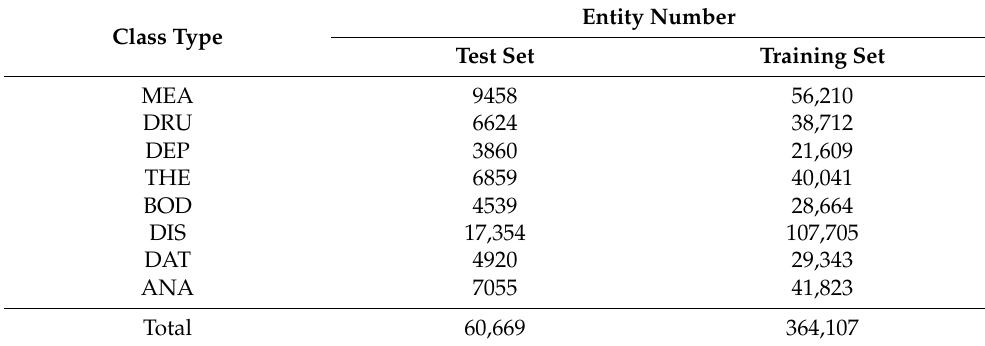
Table 4. Number of entities in the final annotated corpus, split into test set and training